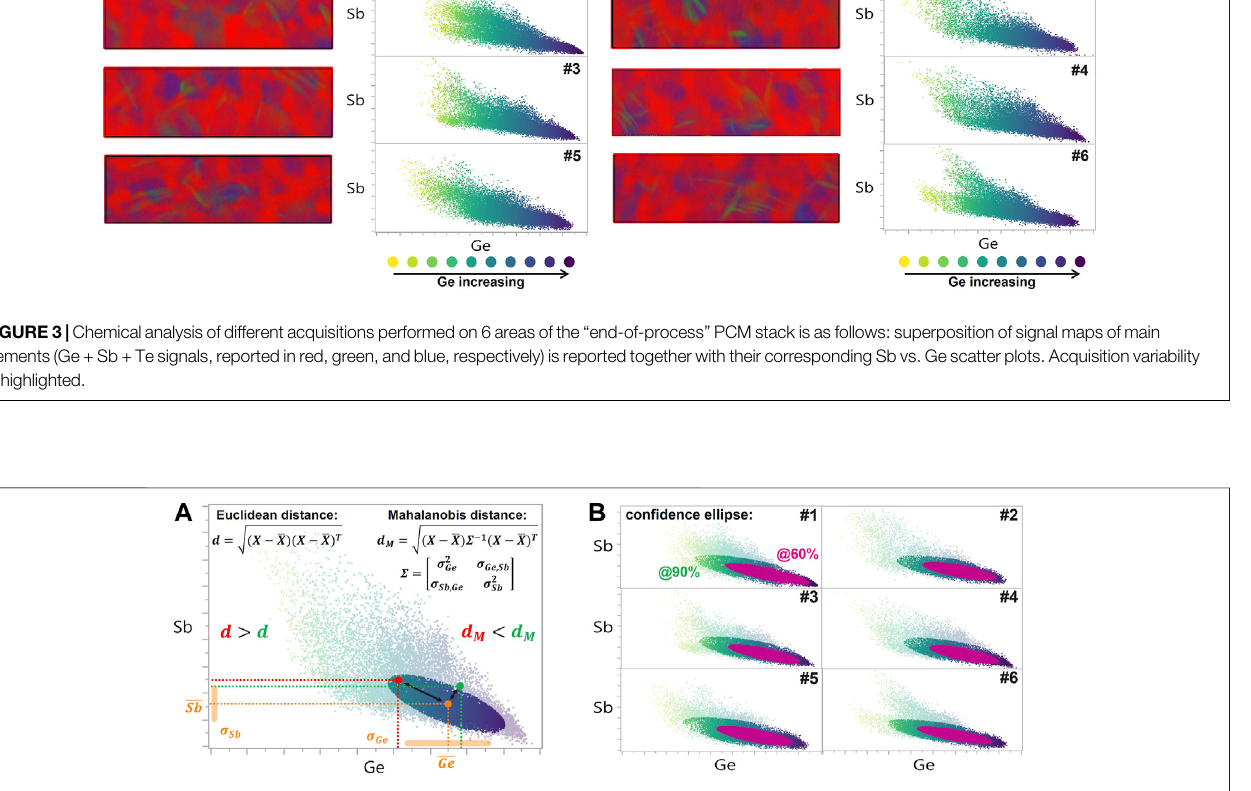
FIGURE 4 | Graphical representation of novel statistical methodology and results: (A) Mahalanobis distance vs Euclidean distance de fi nitions and schematic applications. Red and green points have different distance ratios if calculated by simple Euclidean formula or by considering intrinsic data dispersion; (B) Mahalanobis distanceandcon fi denceellipseconceptsareappliedontheSbvs.Gescatterplotsof Figure3 for60and90%con fi dencelevels.Morecompactandsimilardistributions are highlighted.